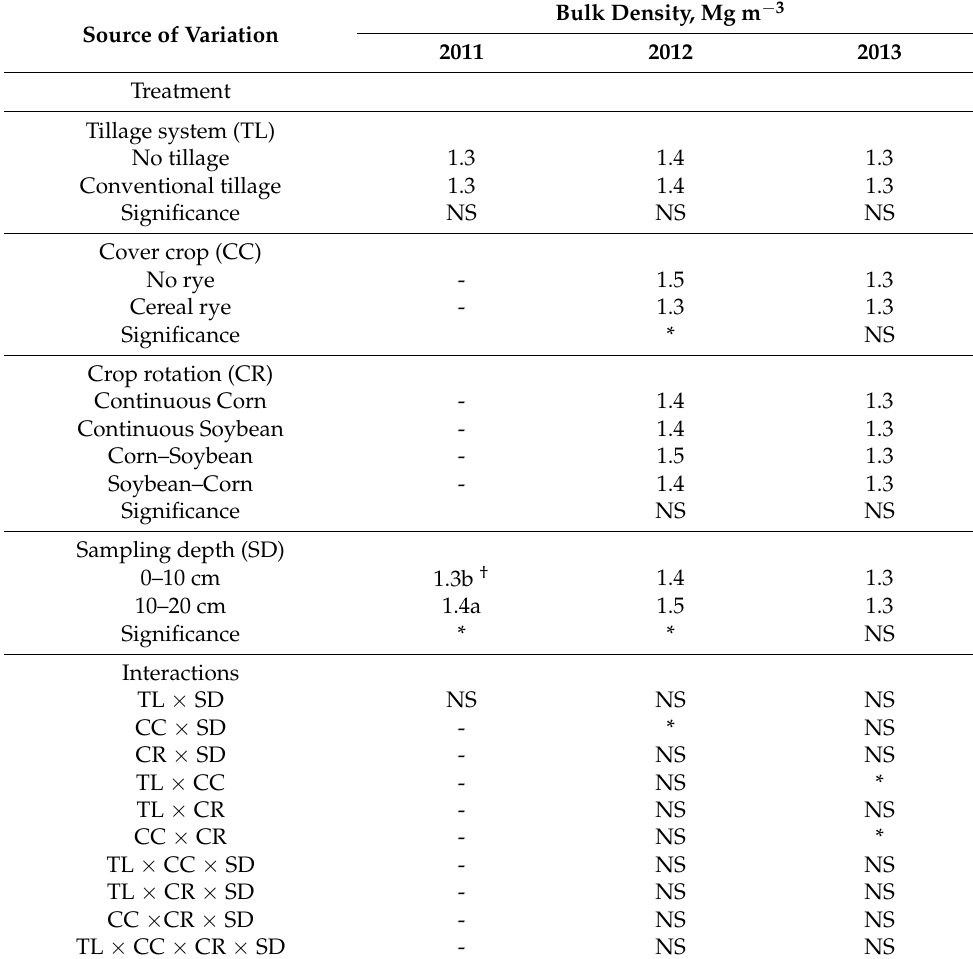
Table 1. Analysis of variance (ANOVA) results with means for bulk density as affected by tillage system, cover crop, crop rotation and sampling depth and their